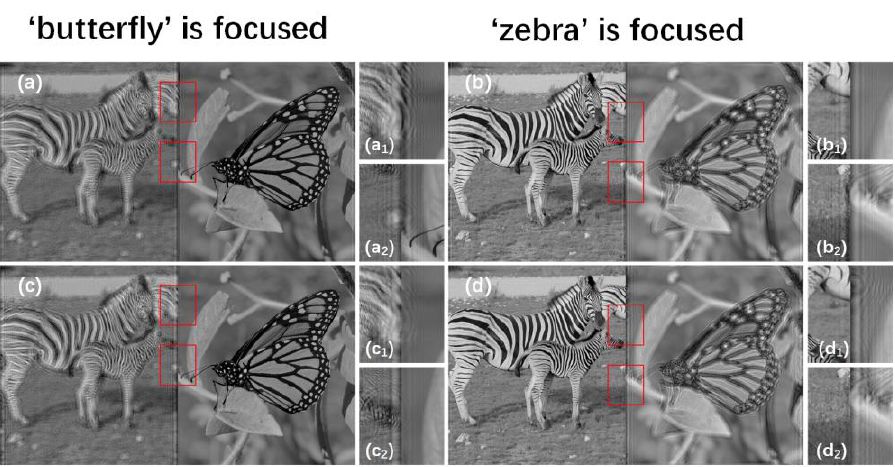
Figure 6. ( a , b ) are the reconstructed results of the SGD method with complex loss function and ( c , d ) are the reconstructed results of the proposed method when the distance z r is 230 mm and ∆ z is 30 mm. ( a 1 – d 1 ) and ( a 2 – d 2 ) are the details of ( a – d ) in the red box region, respectively. Figure 7 shows the SGD method with amplitude loss function to generate multi- depth holograms. The SGD method with amplitude loss function only calculates the am- plitude loss values between the reconstructed images of the hologram and the primitives at each depth.